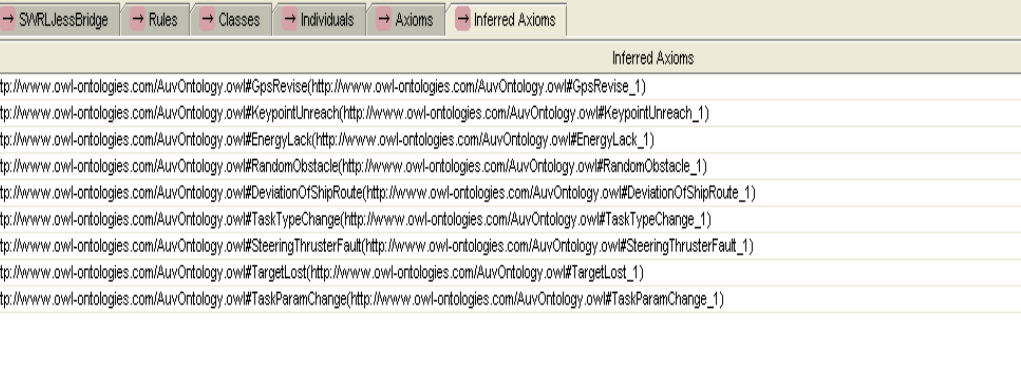
Figure 6. Experimental results of event detection inference based on SWRL rules.